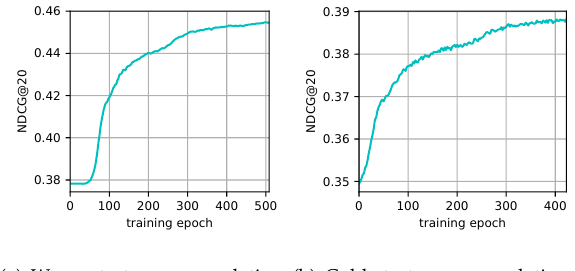
Figure 6. Convergence of our proposed model ADHR on MovieLens1m.